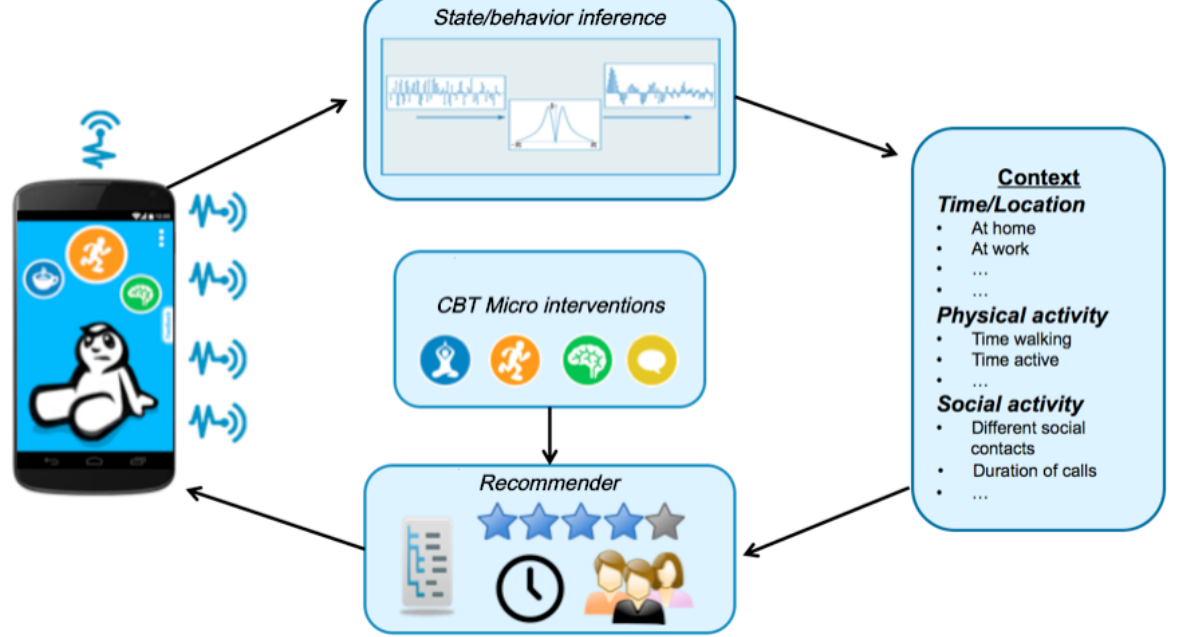
Figure 1. Schematic overview of Mobile Sensing and-Support (MOSS) app process flow. Note: Starting left (1) MOSS app collects sensor and use data, (2) data is analyzed and transformed into (3) context information, (4) context information in combination with user preference and decision logics are used to recommend (5) evidence-based interventions presented via (1) the MOSS